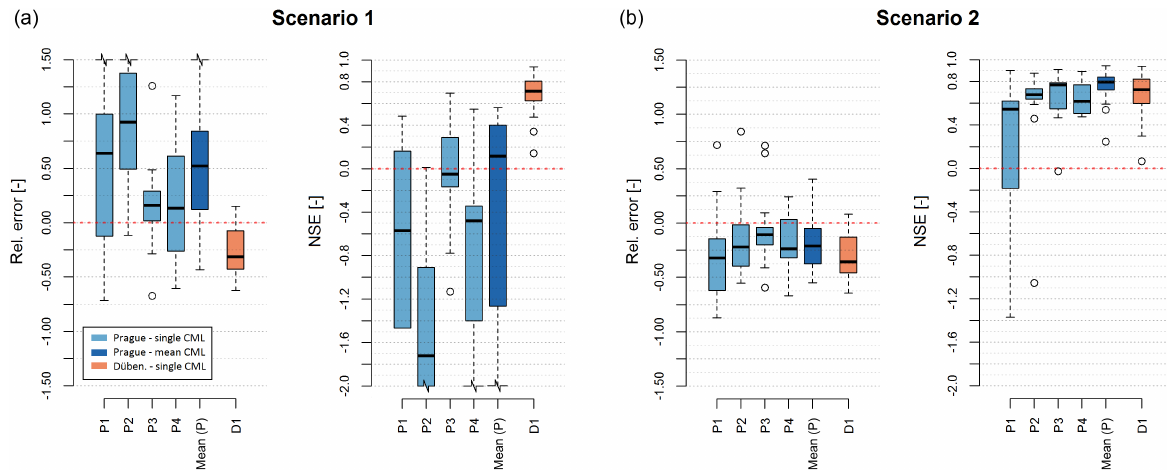
Figure 6. Relative error and NSE in QPEs of unadjusted CMLs evaluated for all events. Each box plot depicts one CML (i.e. CML mean). Scenario 1: QPEs based on models with parameters from the literature. Scenario 2: QPEs based on models with optimal parameters. It can be seen that choosing parameter values for the retrieval model from literature leads to large positive bias (scenario 1, relative error). Conditioning the model on observations leads to a negative bias, albeit with reduced variance. Both do not achieve the virtually unbiased observations obtained with our adjustment method, which are an order of magnitude lower (Fig. 2). The comparably good performance of the CML D1 is due to an exceptional ground truth, which enabled a custom-made wet antenna